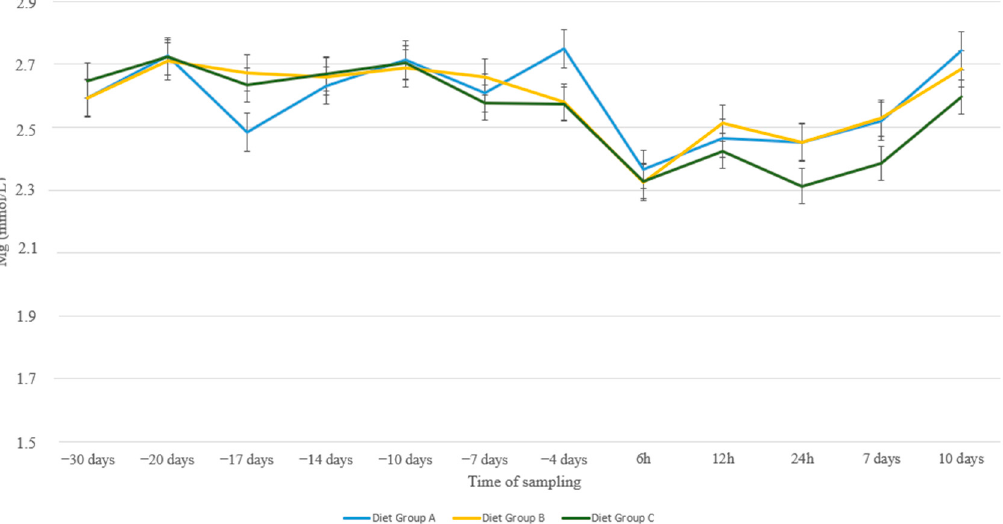
Figure 3. Mg levels (mmol/L) in blood serum of sheep in group A (control group, n = 27), group B (supplemented diet with beet pulp, n = 31), and group C (supplemented diet with beet pulp and anionic salts, n = 29) during the peri-parturient period.